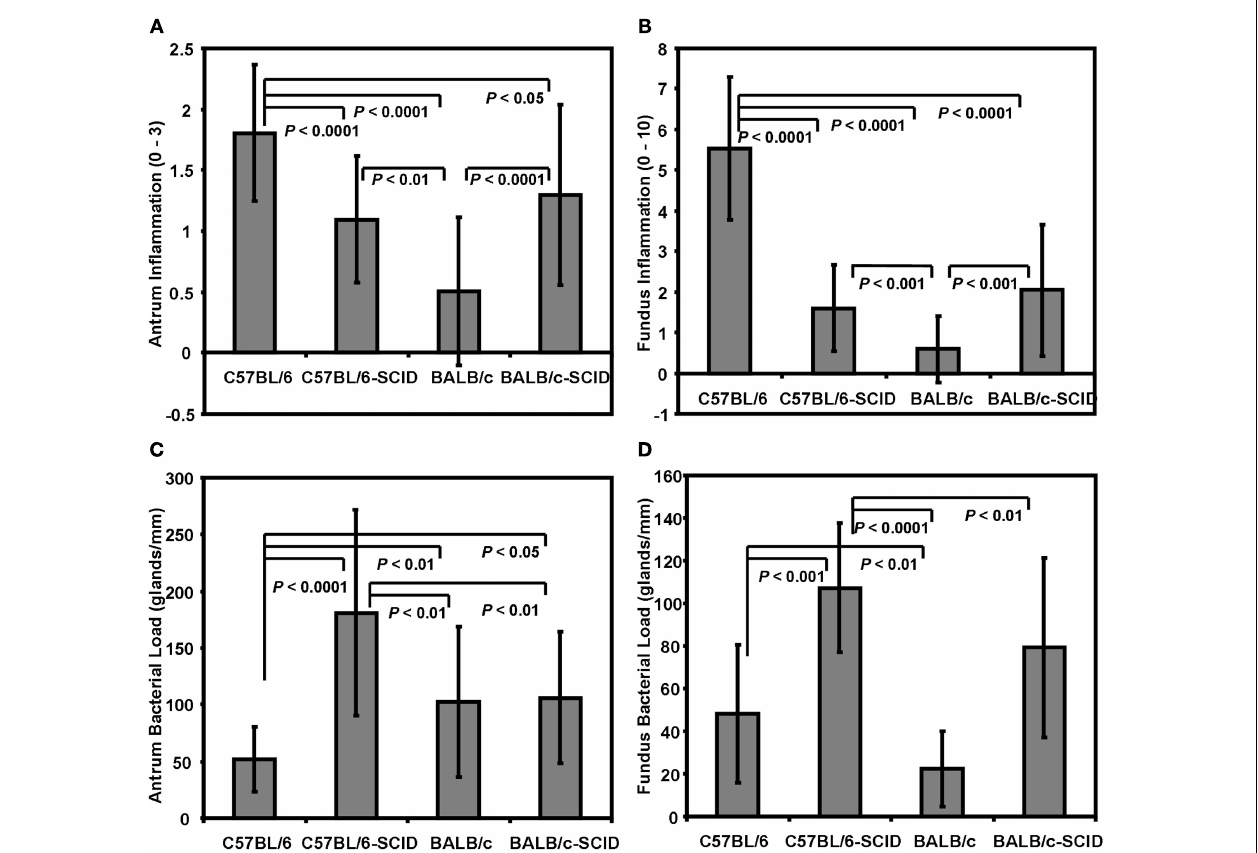
histologic grading of H&E stained longitudinal sections.The bacterial load for both the (C) antrum and (D) fundus were quantified by direct visualization of Steiner (silver) stained section and determining the number of H. felis infected glands per mm of tissue. N = 8–12 mice per